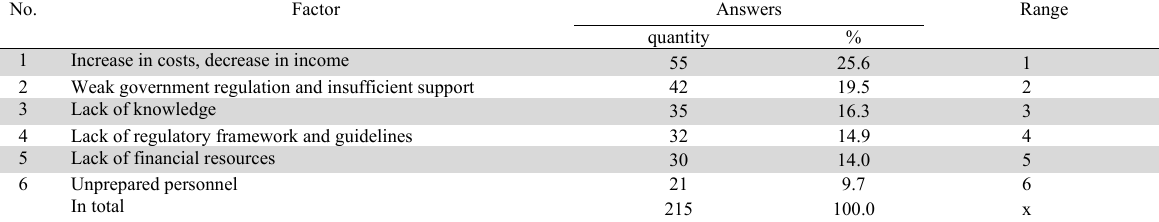
Distribution of answers of managers of agricultural enterprises of Ukraine to the question “What factors prevent the introduction of environmental responsibility in economic activities?”, 2019, units.